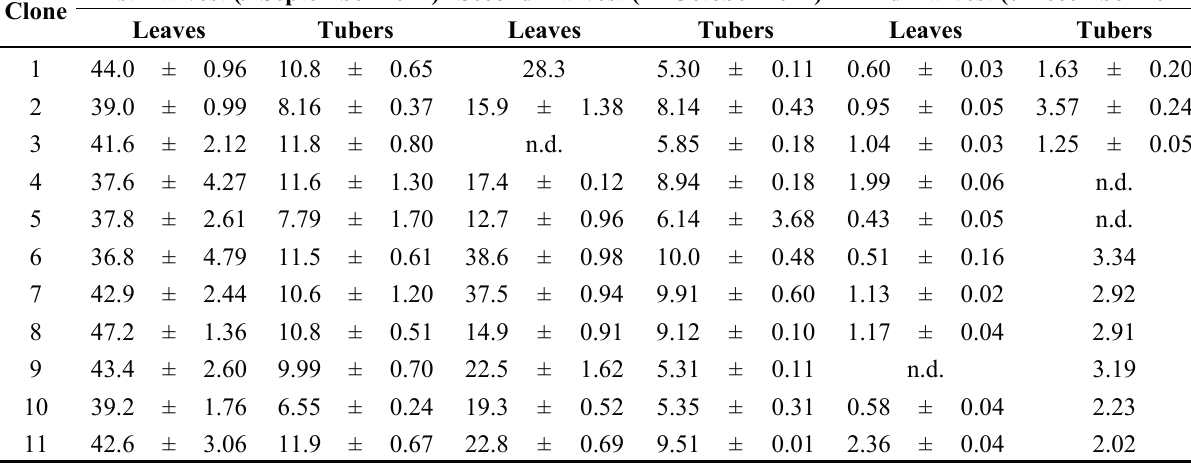
Numbers are representing Mean value ± standard deviation of 3 separate extractions ( n = 3). When standard deviations are missing, all three extractions were not successful. n.d. = not